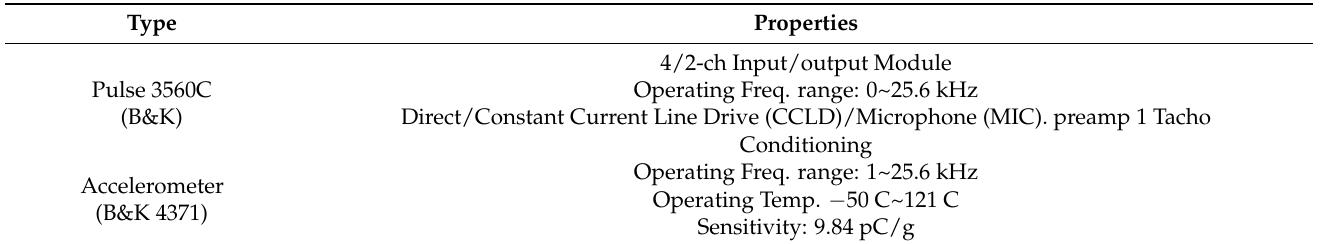
Table 1. Properties of the data acquisition system [3].